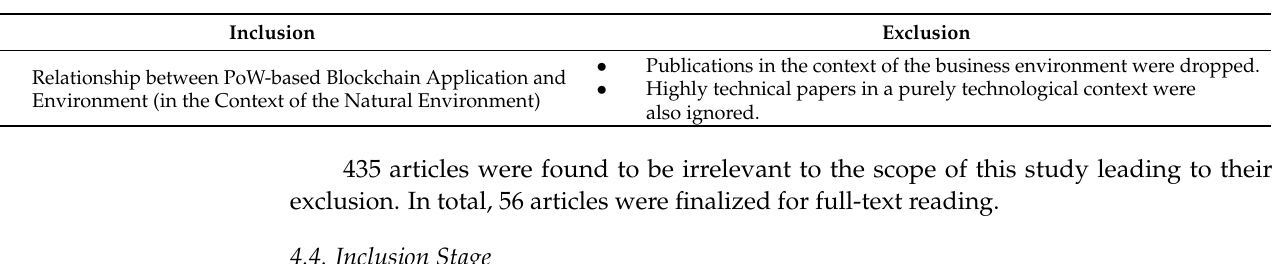
Table 2. Inclusion and Exclusion criteria for the review